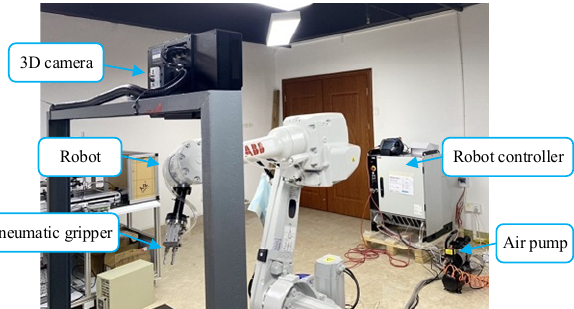
Figure 12. Robotic assembly system. In order to obtain high-quality point cloud data, we used a binocular structured light 3D camera with a point cloud resolution of up to 0.02 mm. Pneumatic grippers were installed at the end of the ABB IRB 2600-20 robot. The clamping state of the pneumatic gripper could be controlled by I/O programming. The robot was controlled by the robot controller.